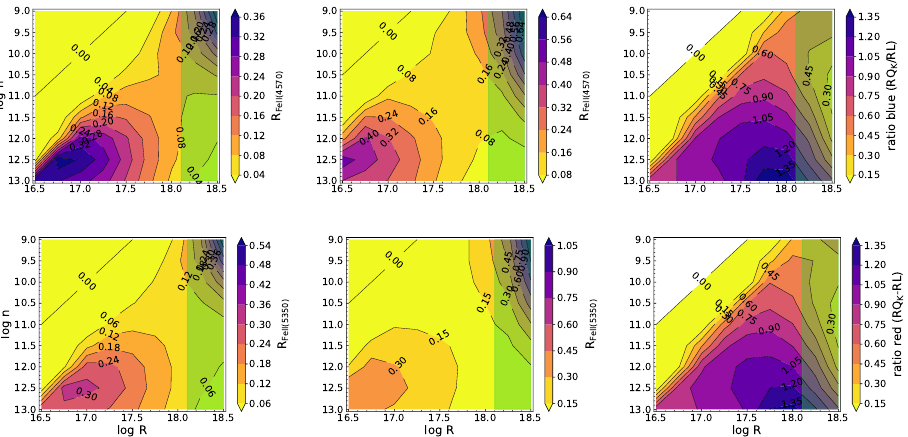
Figure 11. Results of CLOUDY simulations, the same as in Figure 10 but for the RQ SED of Korista et al. [89].